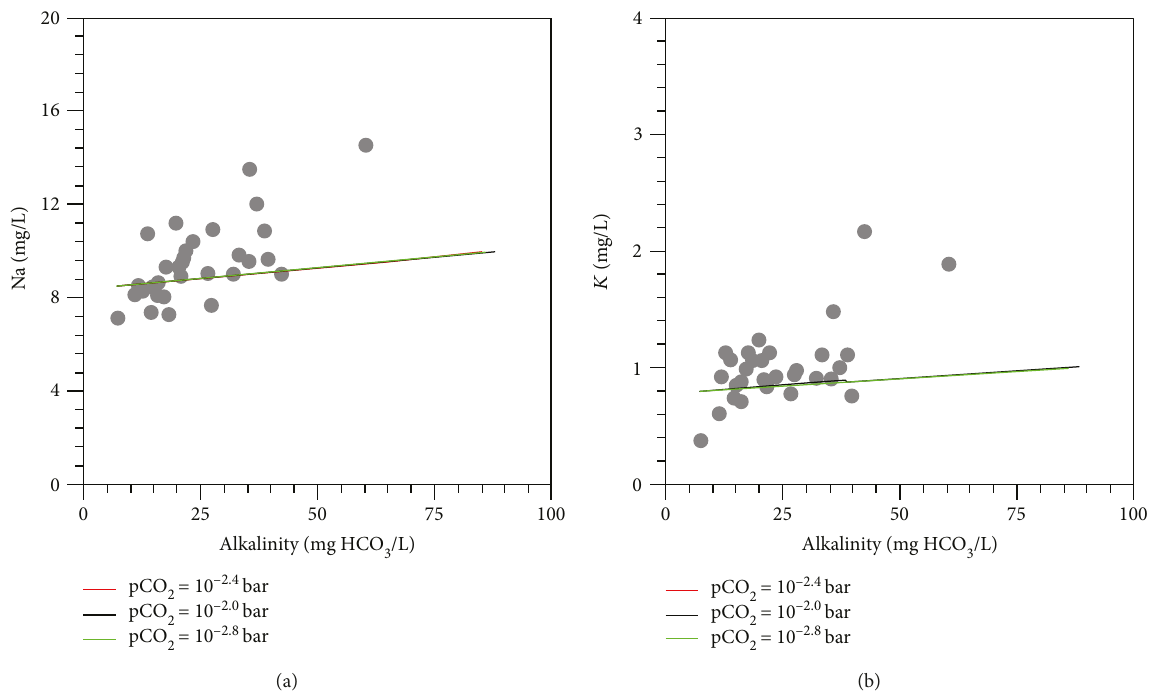
Figure 8: Plots of (a) Na and (b) K vs. alkalinity showing the analytical data from groundwaters interacting with granulitic rocks of the lower crust as well as the results of reaction path modeling for granulite dissolution under di ff erent pCO